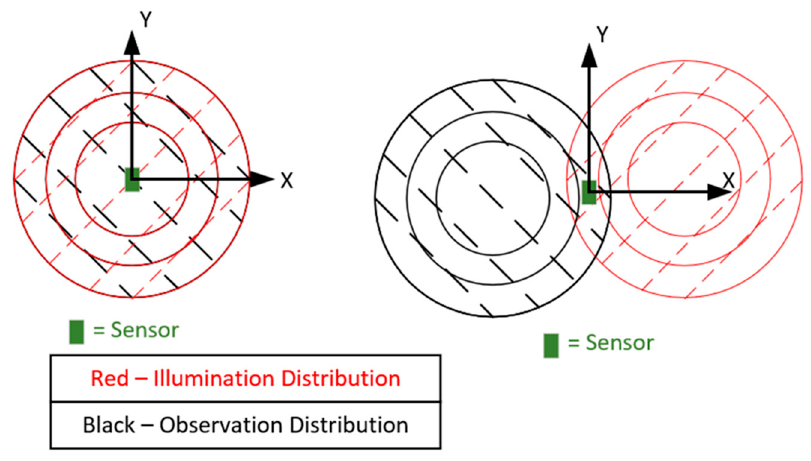
Figure 16. Diagram of fully and partially overlapped observation and illumination patterns.